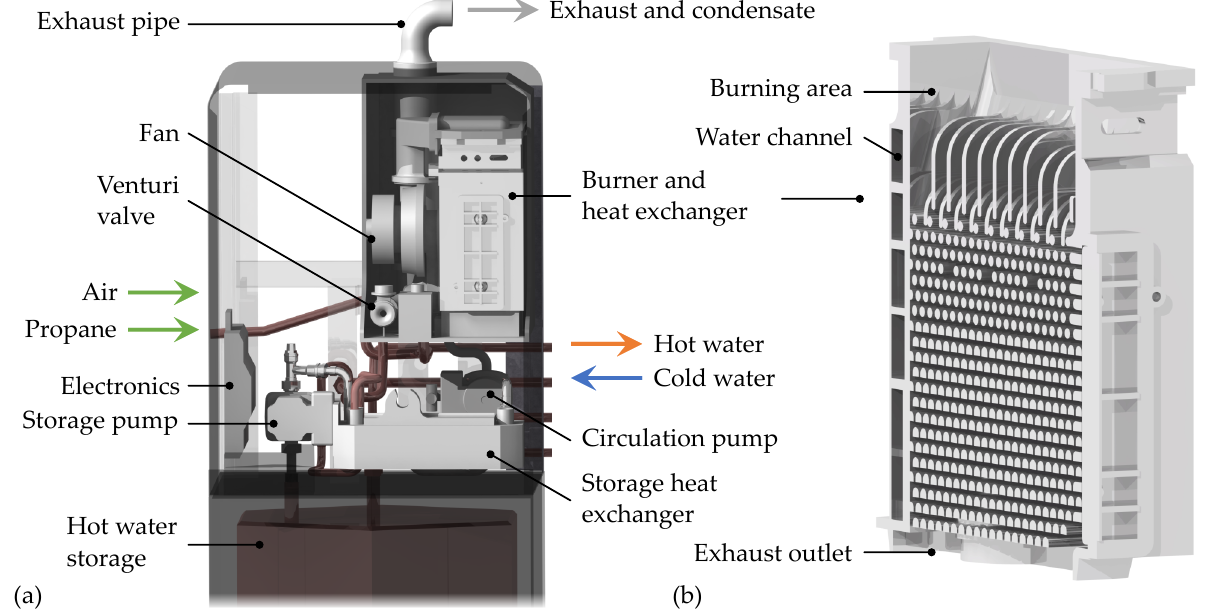
Figure 1. ( a ) Composition of the condensing boiler and its interfaces; ( b ) Detailed sectional view of the integrated burner and heat exchanger of the